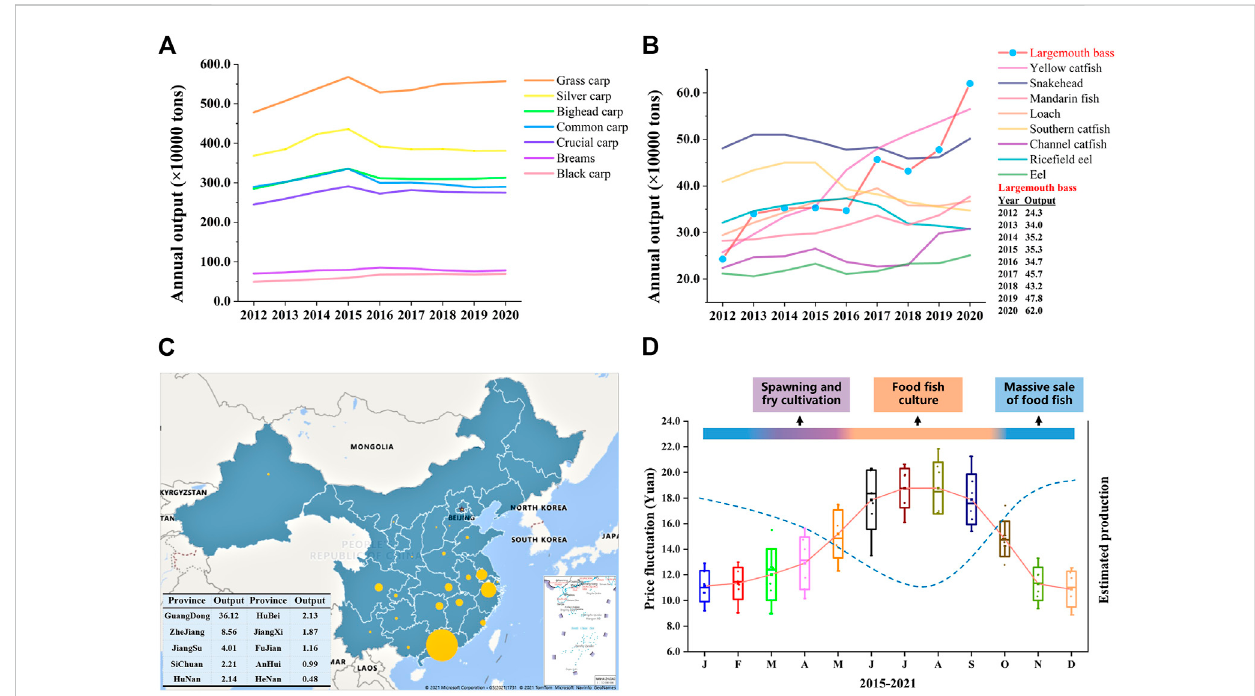
FIGURE 1 Annualproduction change ofthetop16 freshwater fi sh speciesand productiondistribution andprice fl uctuation oflargemouthbassinChina. (A, B) The annual production output of the top 16 fi sh species ( > 0.2 million tons), including seven staple/conventional freshwater fi sh species and nine special freshwater species, from 2012 to 2020 in China. Tilapias are not listed because they are mainly exported. ( C) Aquaculture production of largemouth bass in different provinces of China in 2020. The size of the bubble refers to the amount of production for the corresponding province. The top 10 producers of largemouth bass are listed in the table. Annual production data were obtained from the China Fishery Statistical Yearbook (China Bureau of Fisheries). ( D) Annual average price fl uctuation of largemouth bass and estimated production (dotted line), showing the supply – demand relationship. Each box represents the price data of the same month from 2015 to 2021, and the solid line represents the average annual price fl uctuation trend. Datafor theprice,representingpond-side priceor purchasing pricewhich istheprice thatthedealer offers tothe fi shfarmer,werecollected from the China Fisheries Channel website (http://www. fi sh fi rst.cn/) and China Aquaculture website